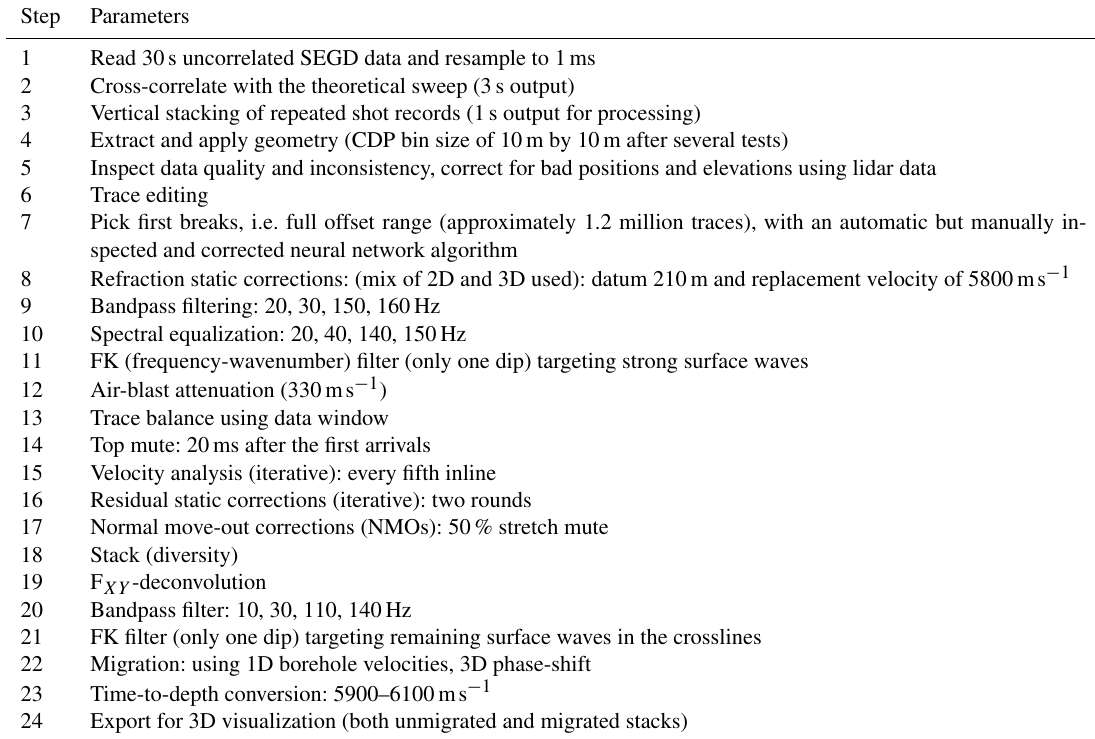
Table 2. Principal processing steps applied to the Blötberget 3D dataset